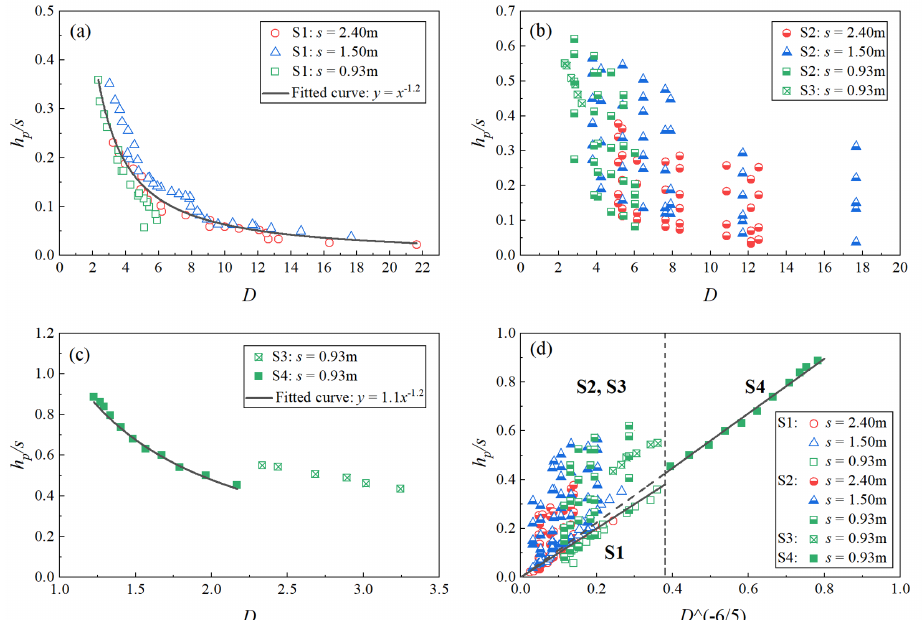
Figure 3. Dimensionless water level versus drop parameter at: ( a )stage S1; ( b ) stage S2 and stage S3; ( c ) stage from S3 to S4; ( d ) all transition